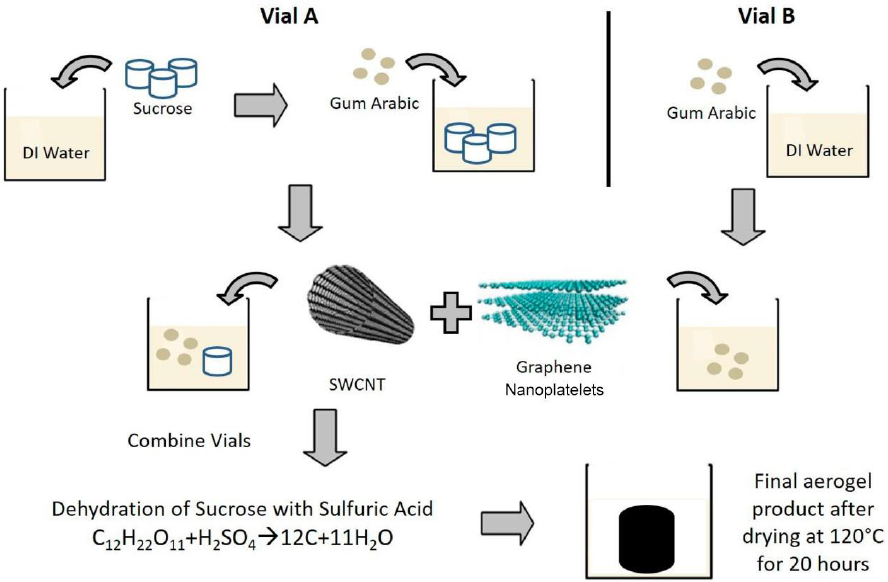
Figure 15. Schematic showing the process of making carbon-nanomaterial-based aerogel from carbon nanotube, graphene oxide, and carbonized sucrose and acacia gum. Reprinted with permission from [52]. Copyright © 2018 American Chemical Society.